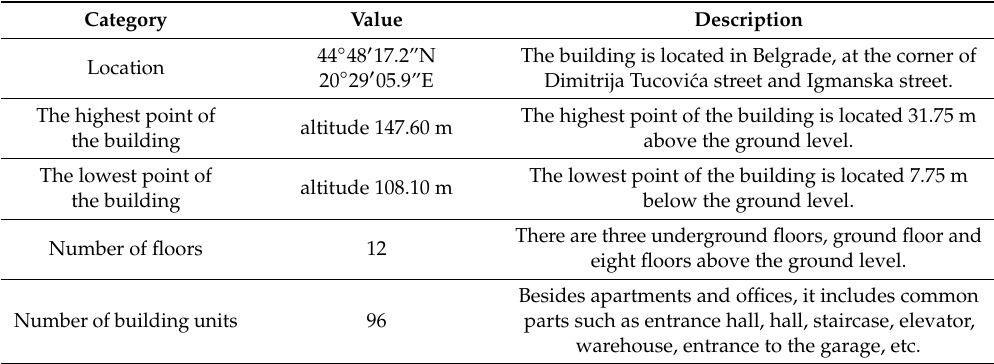
Table 2. Description of the case study building.